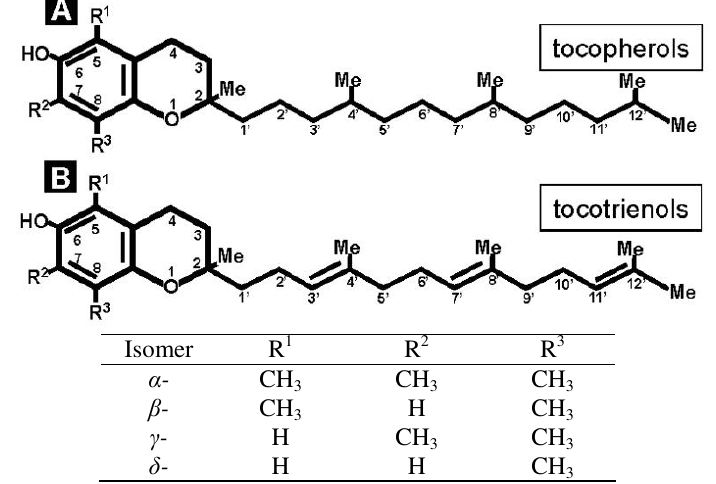
Figure 1. Structures of tocopherol and